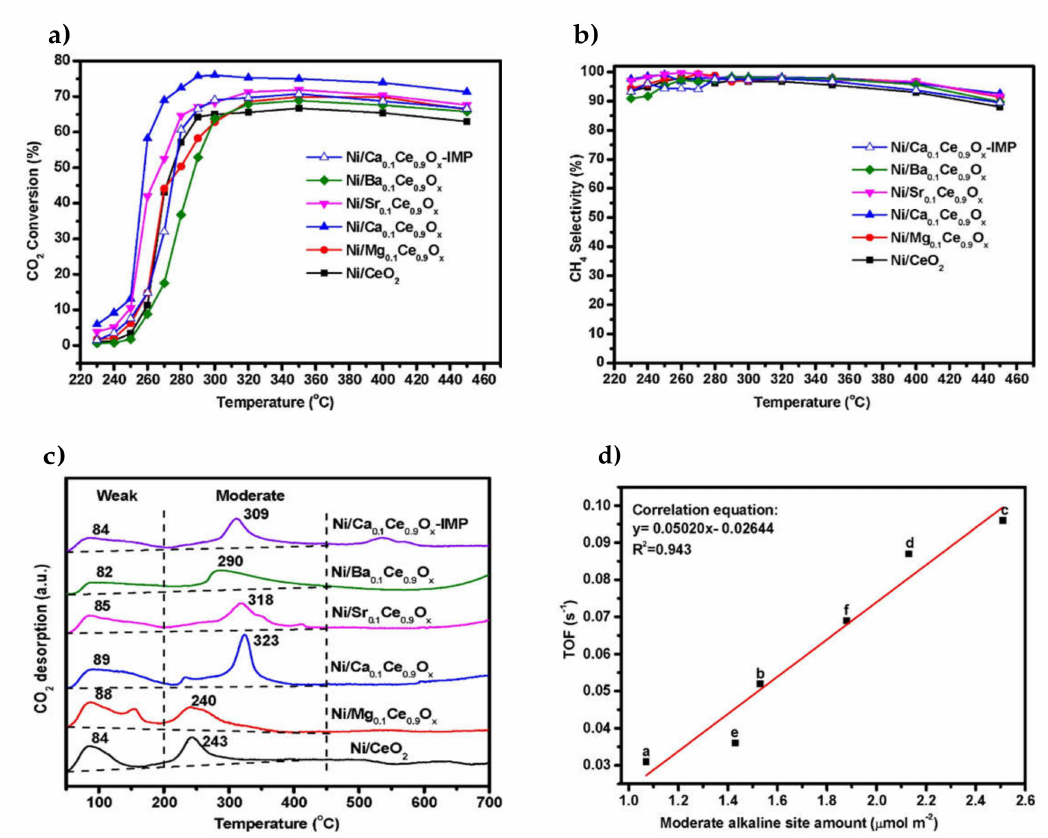
Figure 4. CO 2 conversion ( a ) and CH 4 selectivity ( b ) of the Ni / M 0.1 Ce 0.9 O x catalysts; WHSV = 36,000 mL h − 1 g − 1 . ( c ) CO 2 desorption profiles of the Ni / M 0.1 Ce 0.9 O x catalysts and ( d ) Linear relationship between the TOF values at 250 ◦ C and the amount of surface moderate alkaline sites on the Ni / M 0.1 Ce 0.9 O x catalysts. a. Ni / CeO 2 ; b. Ni / Mg 0.1 Ce 0.9 O x ; c. Ni / Ca 0.1 Ce 0.9 O x ; d. Ni / Sr 0.1 Ce 0.9 O x ; e. Ni / Ba 0.1 Ce 0.9 O x ; f. Ni / Ca 0.1 Ce 0.9 O x -IMP. Reproduced with permission from ref. [30]. Copyright 2020